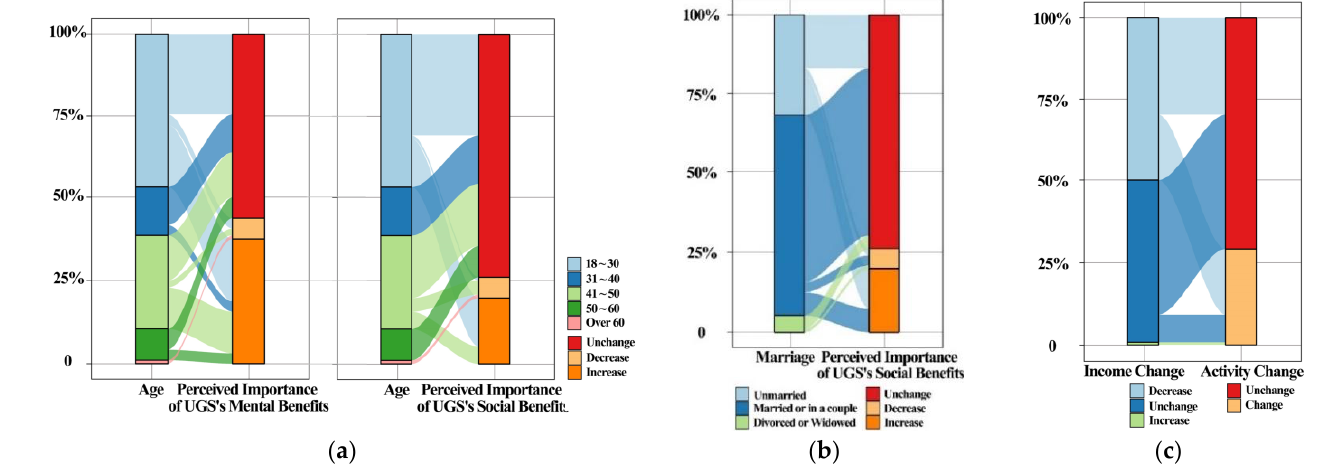
Figure 5. Cross figure of certain demographic characteristics and dependent variables related to changes. ( a ) Age and perceived importance of mental and social benefits, ( b ) Marriage and perceived importance of social benefits, ( c ) Income change and activity change.